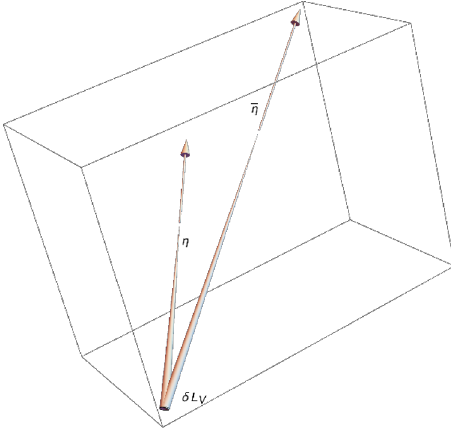
Figure 4 . Schematic demonstration of (cid:17) and (cid:22) (cid:17) trajectories from decay of X . The arrows show the directions of the momenta of (cid:17) and (cid:22) (cid:17) which can be reconstructed by measuring the momenta of the (cid:12)nal lepton pairs. The narrow cones show the reconstructions of the trajectories of (cid:17) and (cid:22) (cid:17) , taking into account the uncertainties in determination of the momenta of (cid:17) and (cid:22) (cid:17) . The opening angles of the narrow cones are characterized by (cid:1) (cid:18) (cid:17) . The X decay vertex lies within the region where the two narrow cones intersect. The region is denoted by (cid:14)L V